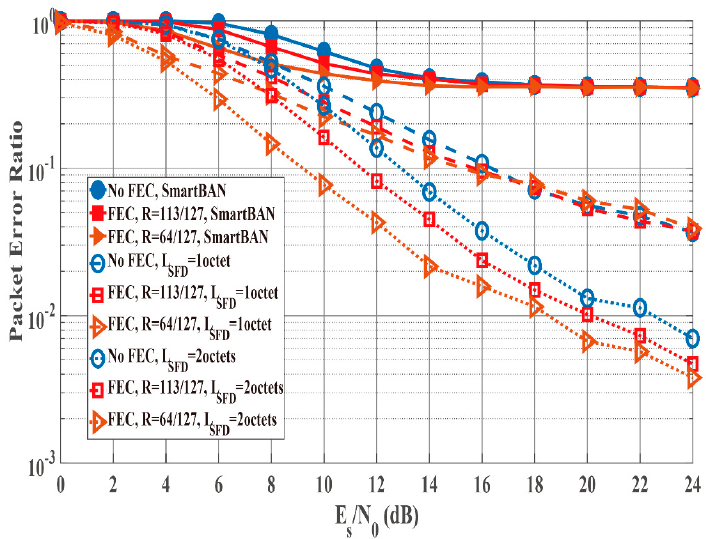
Figure 12. PER performance as a function of E s / N 0 ( K factor = 4.5). Cases of without and with an SFD ( L SFD = 1 octet and 2